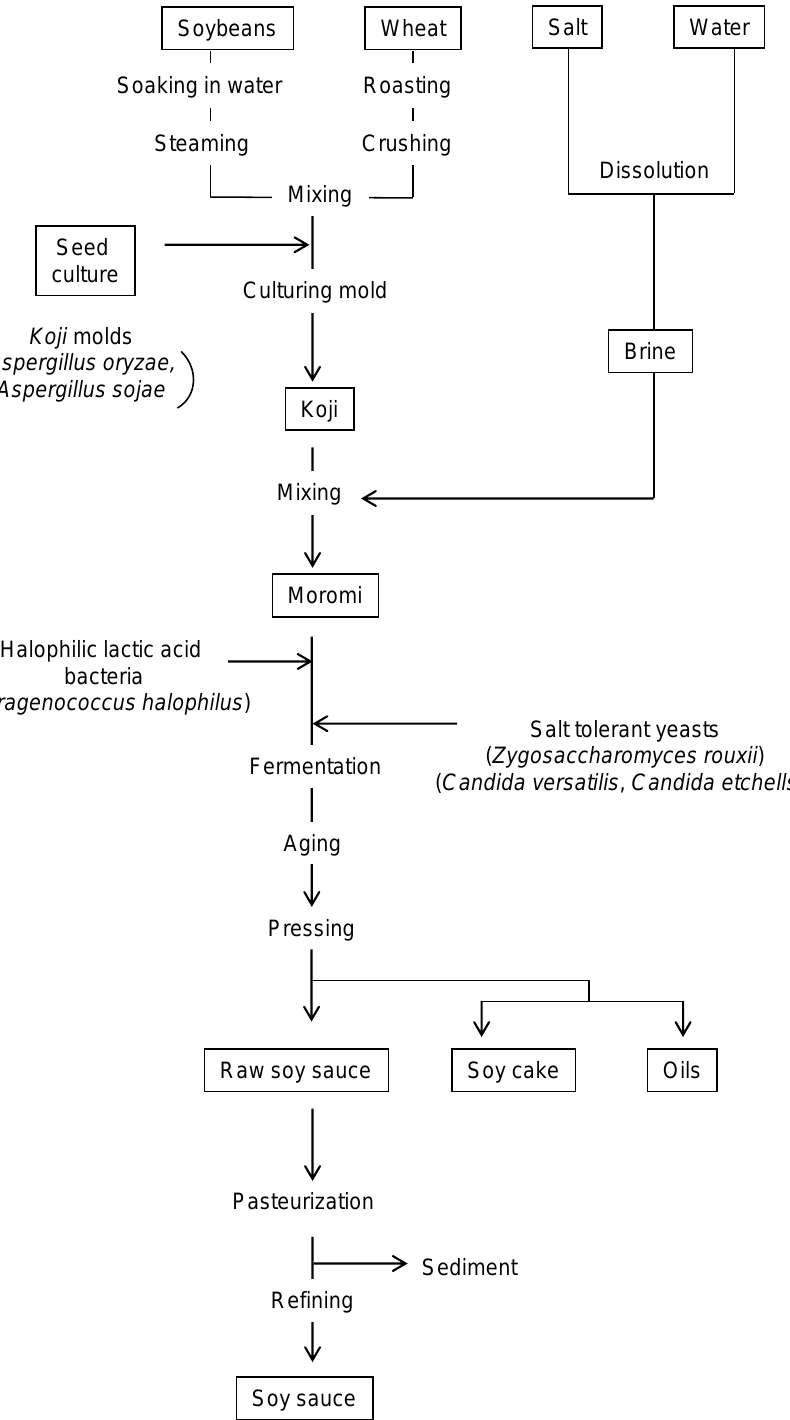
Figure 1. Traditional manufacturing process of soy sauce based on “honjozo,” a Japanese brewing